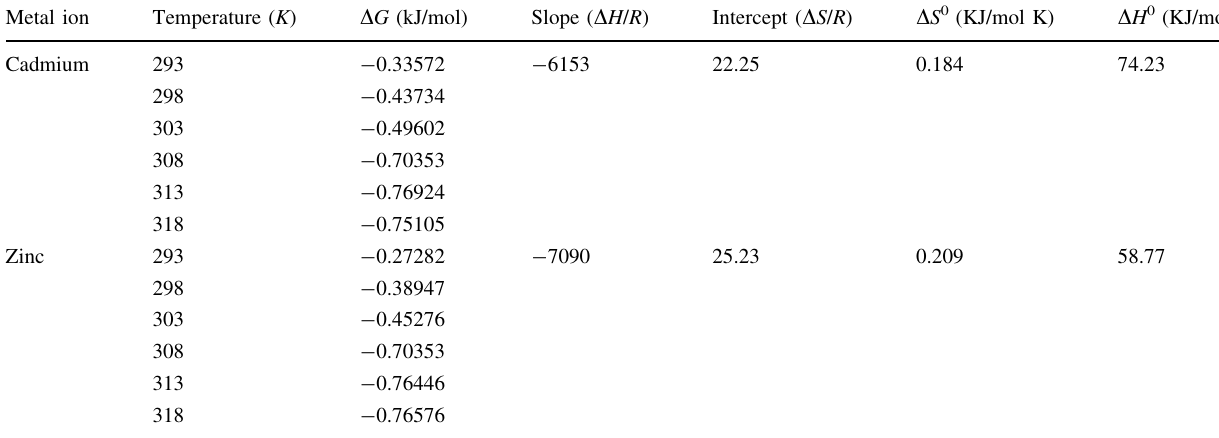
Table 4 Thermodynamic constants for the adsorption of Cd 2 ? and Zn 2